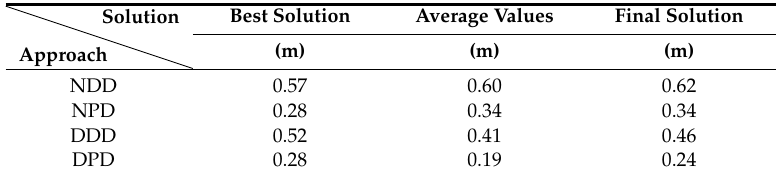
Table 2. MAE regarding the simulated pressure of the Best solution, the Average values and the Final solution with respect to the reference network.